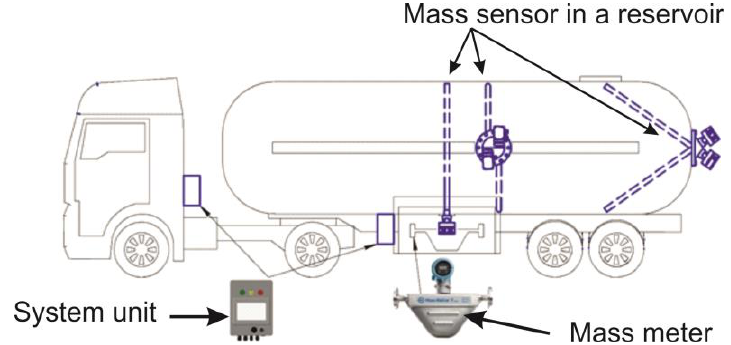
Fig. 8. Position of the equipment in a gas tank